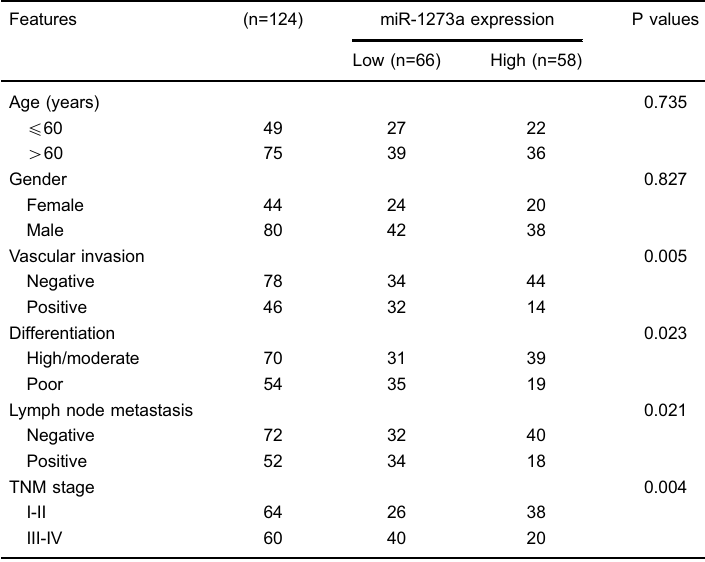
Table 1. Association of miR-1273a expression level with clinical characteristics of colon cancer